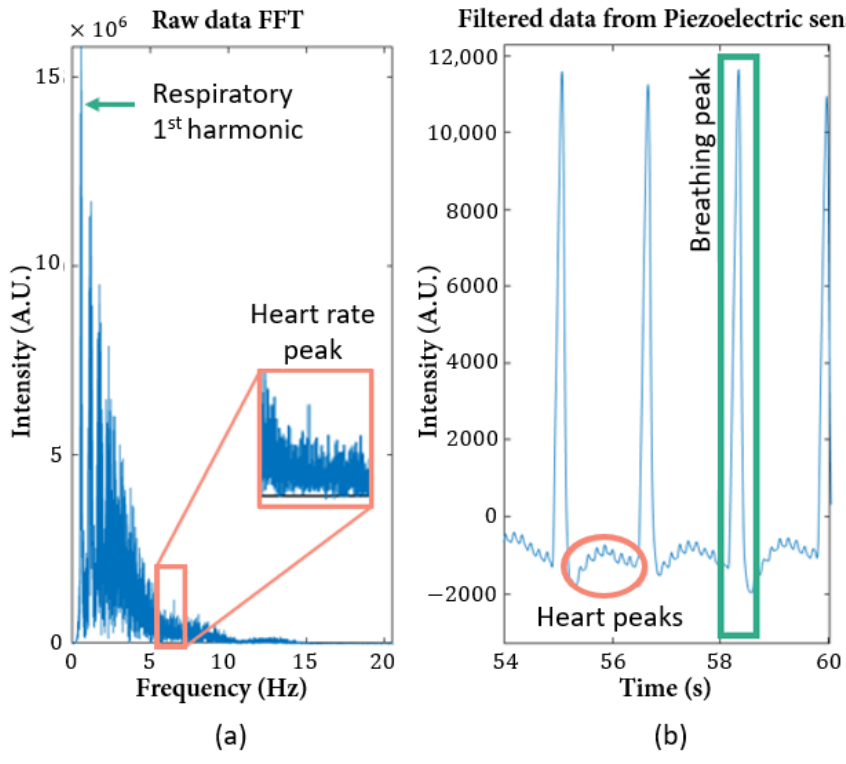
Figure 8. Piezoelectric signal analysis, with 5% of sevoflurane (Mouse 2): ( a ) representation of the absolute value of the signal’s FFT; ( b ) signal filtered with a bandpass filter of 0.1 and 15 Hz as cut-off frequencies, where it is possible to clearly distinguish the heartbeat wave from the respiratory